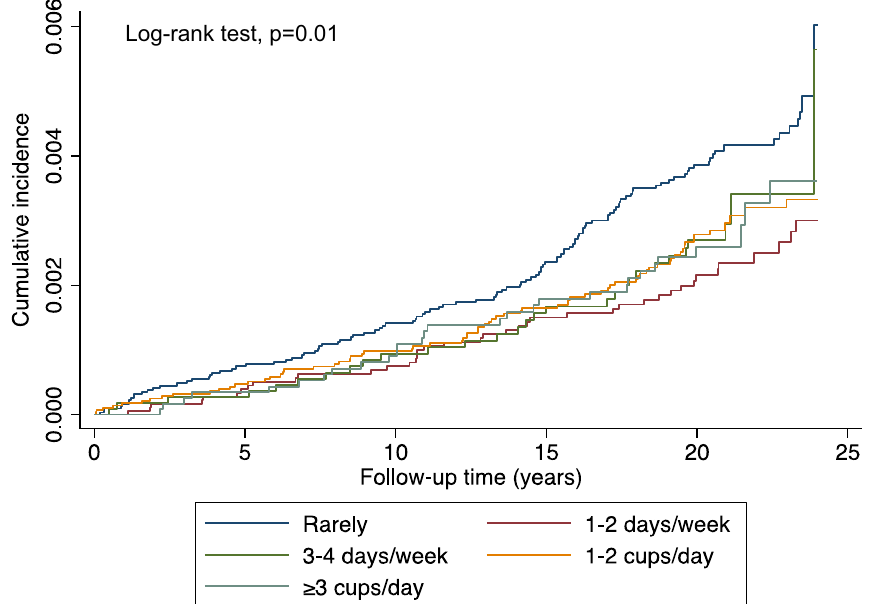
Figure 2. Kaplan–Meier survival curves of the cumulative incidence of kidney cancer among JPHC participants with different coffee consumption.